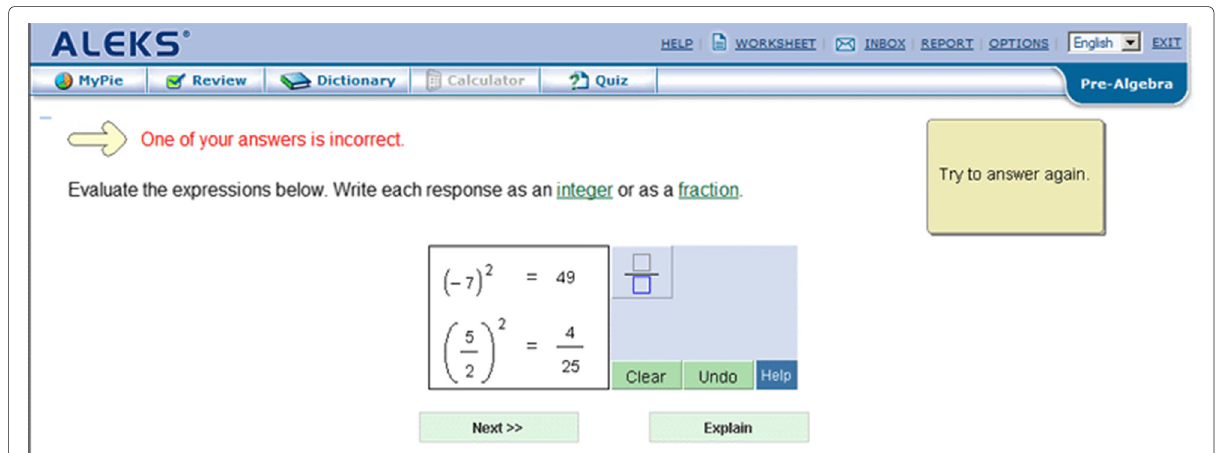
Fig. 2 ALEKS problem: attempting a problem, with options to submit (“Next”) or “Explain”